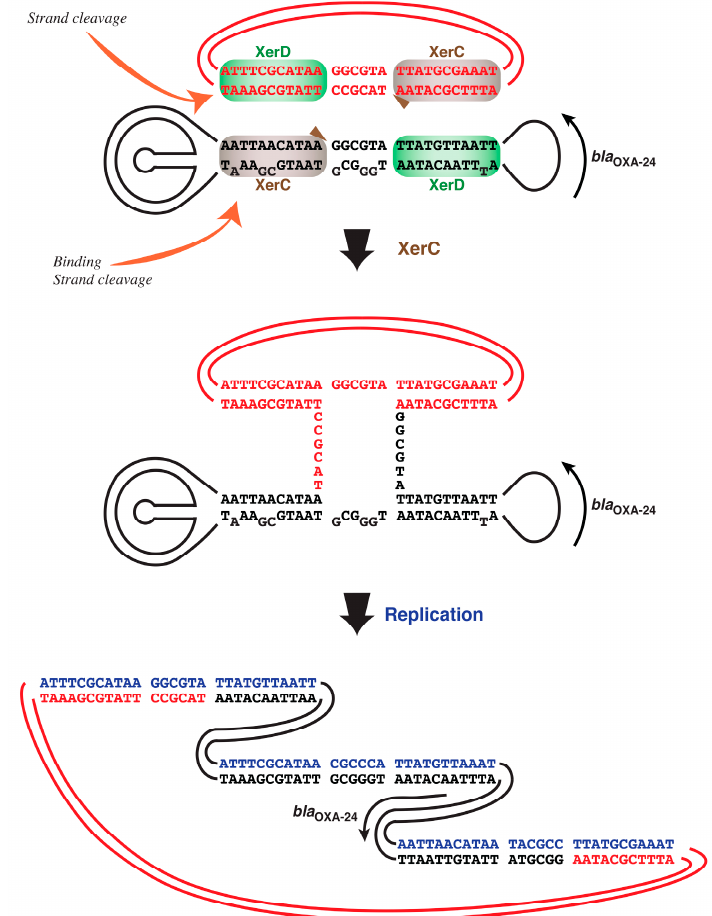
Figure 3. Hypothetical generation of the XerC / D binding sites found in the plasmid pMMCU1. The diagram shows a hypothetical recombination / replication process between two DNA molecules that produced the structure found in pMMCU1. The molecule represented in black includes blaOXA-24 flanked by XerC / D binding sites in opposite orientations. As a consequence, both strands can fold into imperfect hairpin structures that create XerC / D binding sites. The red molecule includes a XerC / D binding site that recombines with that formed by the black molecule hairpin. Blue nucleotides are those in the newly replicated strand. The nucleotide sequences and arrangement of the plasmid at the bottom are those of the plasmid pMMCU1 (accession number GQ342610) [21]. Orange arrows show the experiments performed using the oligonucleotides